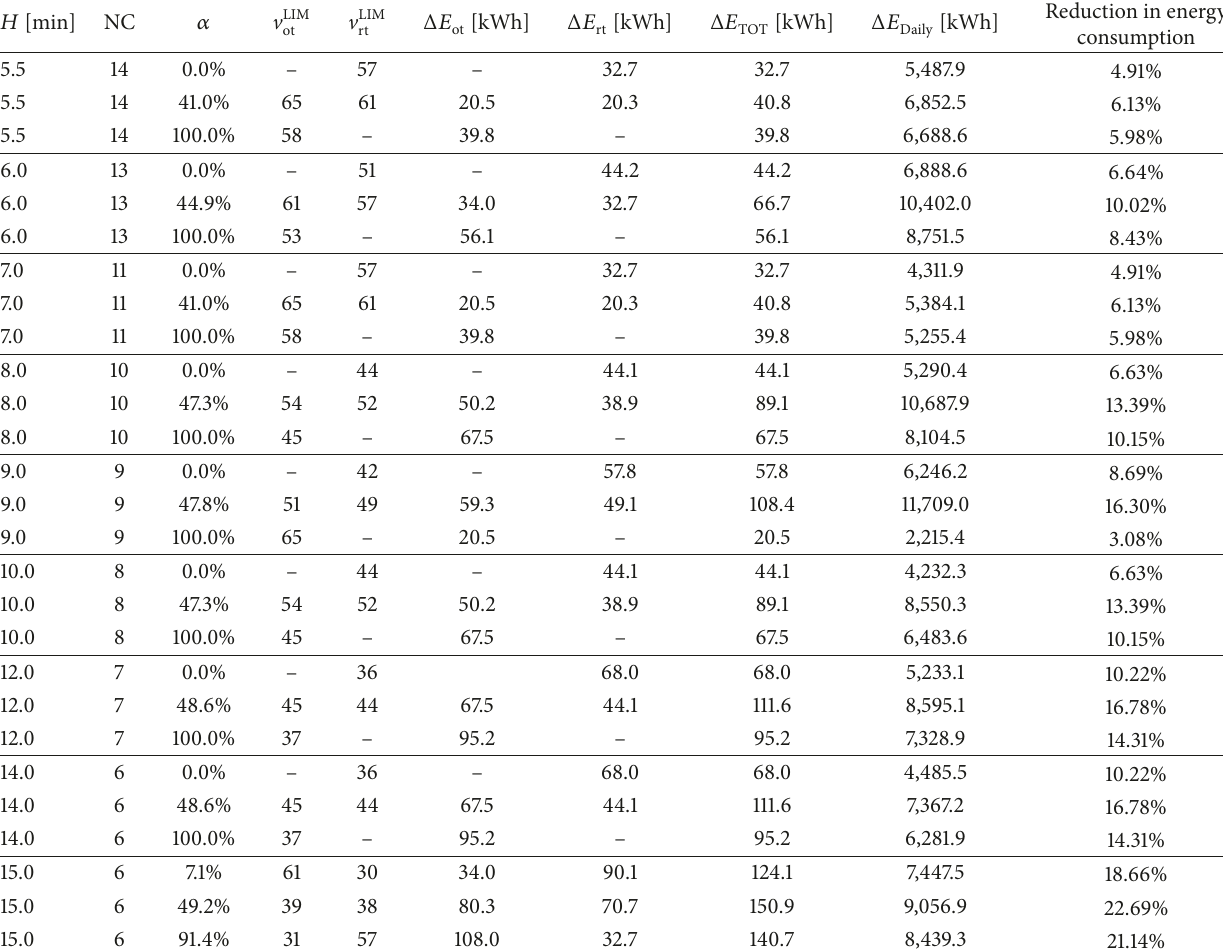
Table 6: Energy variations in the case of the 90th